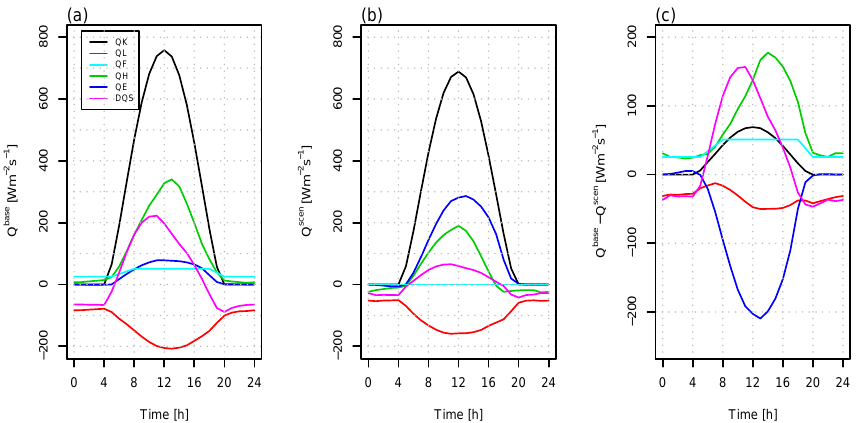
Fig. 6. The 5-day averaged diurnal cycle of the surface energy fluxes at Paris-Montsouris (city centre) for the base run (a) , the scenario run (b) and their difference (c)